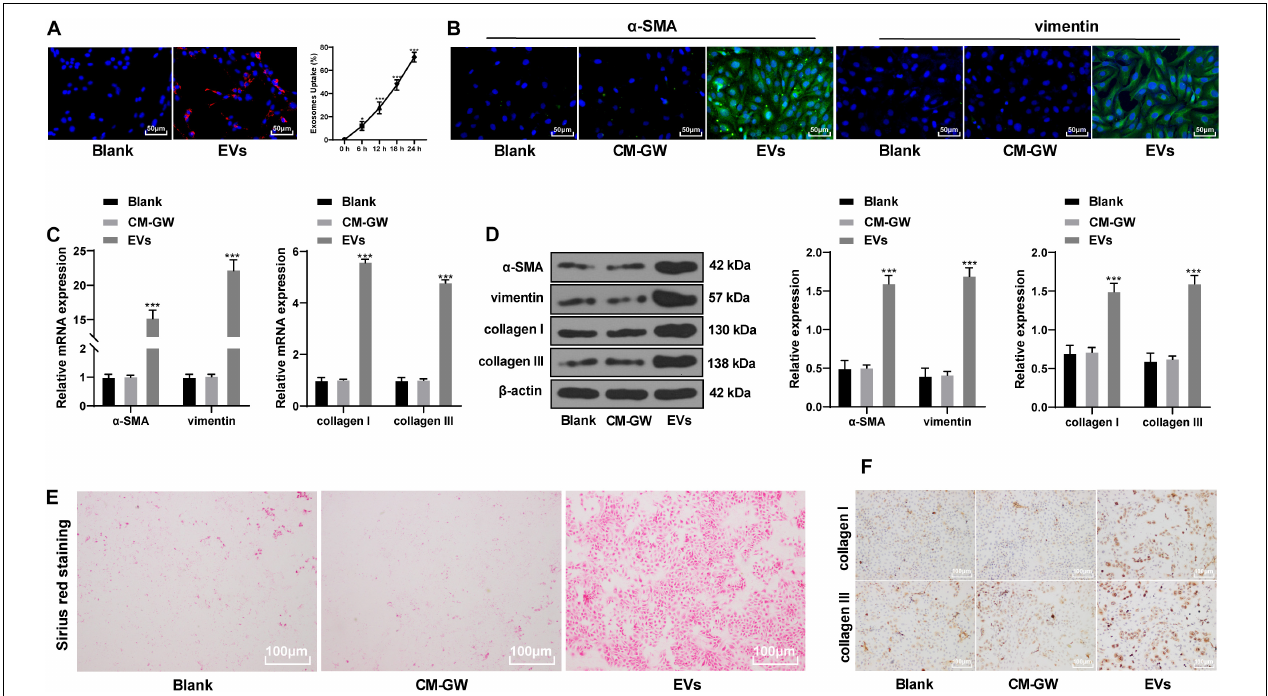
FIGURE 2 | EVs derived from hepatoma cells promoted the differentiation of BMSCs into fibroblasts. (A) Dil was used to label the EVs and to find the internalization of the EVs by BMSCs. Compared with 0 h, * p < 0.05, *** p < 0.001. (B) The expression of α -SMA and vimentin in BMSCs was detected by immunofluorescence. The stronger the green fluorescence, the higher the positive expression. (C,D) The levels of α -SMA, vimentin, collagen I, and collagen III in EVs-treated BMSCs were detected by RT-qPCR and Western blot analysis; compared with the blank group, *** p < 0.001. (E) Picric acid-Sirius red staining measured the collagen deposition in BMSCs. (F) levels of type I collagen and type III collagen in EVs-treated BMSCs were measured by immunocytochemistry. Data were analyzed by one-way ANOVA, followed by Tukey’s multiple comparison test. Replicates = 3.